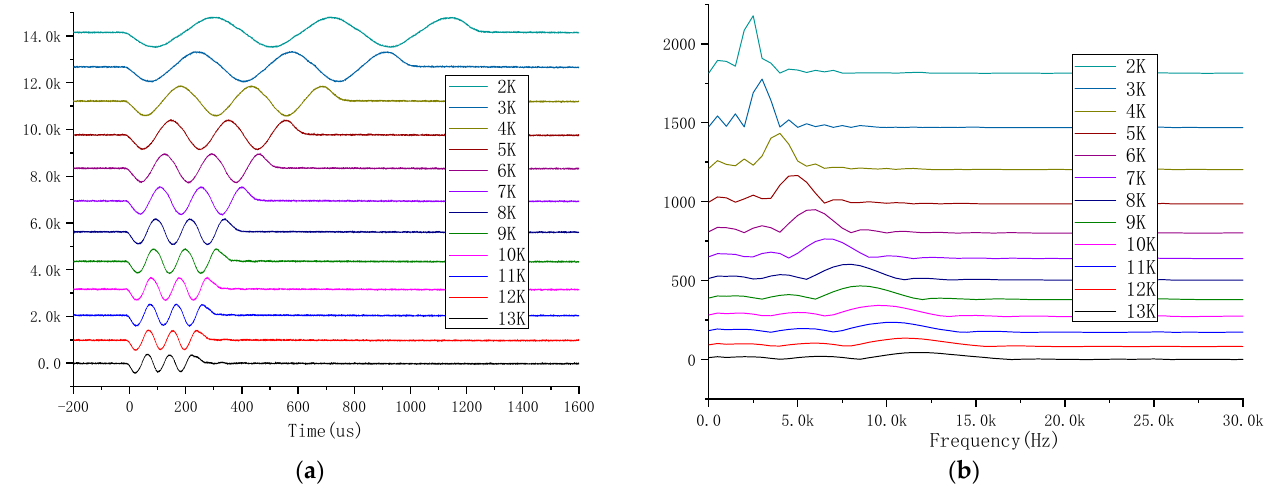
Figure 8. Time ‐ domain ( a ) and spectrum waves ( b ) excited by SPWM excitation circuit. Figure 8. Time-domain ( a ) and spectrum waves ( b ) excited by SPWM excitation